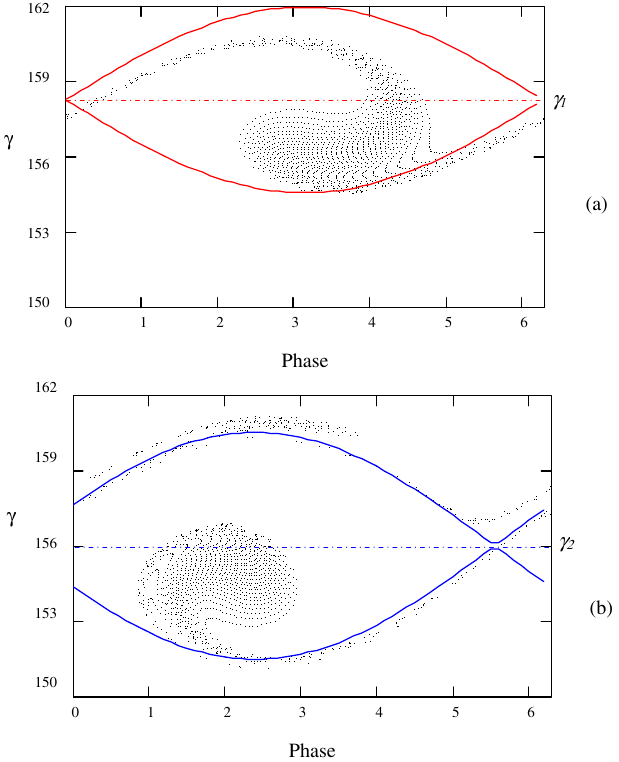
FIG. 2. (Color) Longitudinal phase space (a) at the end of the first wiggler segment, and (b) at the end of the second wiggler segment.